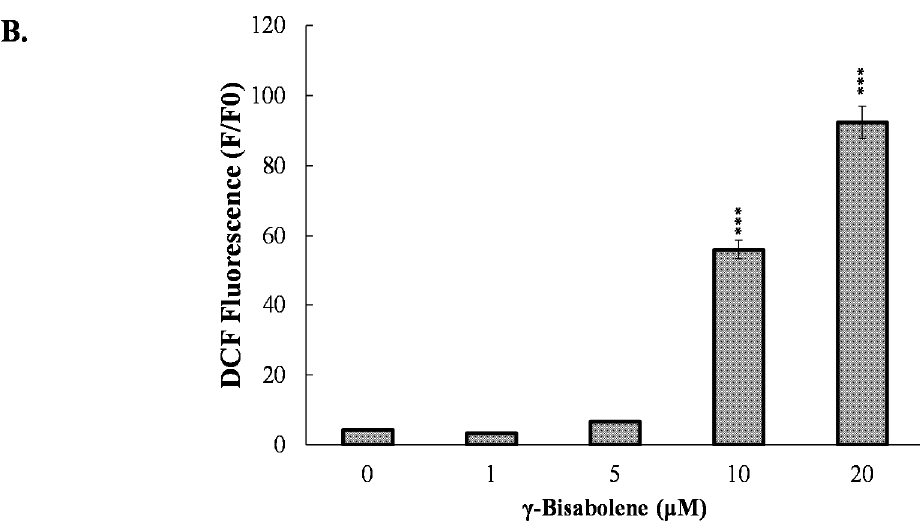
Figure 4. Increase of intracellular ROS production in γ -bisabolene-treated cells. Cells were treated with γ -bisabolene for 48 h, harvested stained using DCF-DA, and then analyzed by flow cytometry with excitation and emission spectra of 495 nm and 529 nm respectively ( A ); Relative fluorescent intensity of DCF was further calculated ( B ). ***, p value < 0.001 compared with untreated cells.